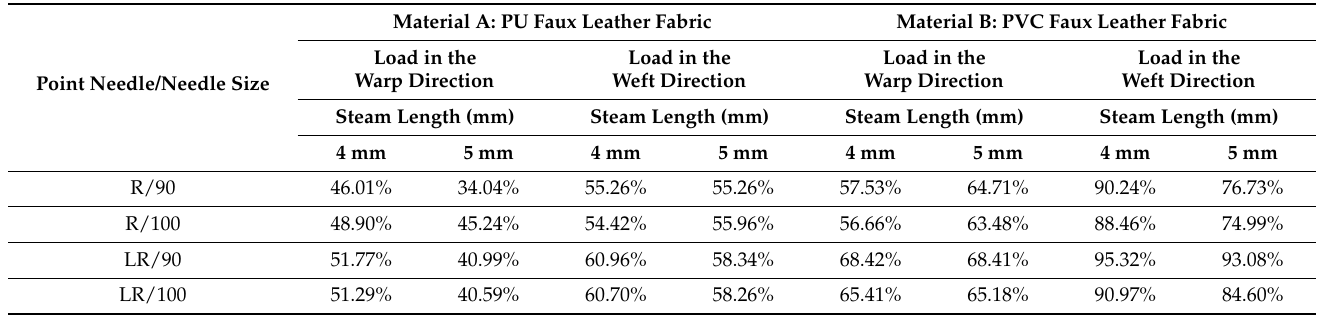
Table 5. Seam efficiency for Faux Leather Fabric. Material A: PU Faux Leather